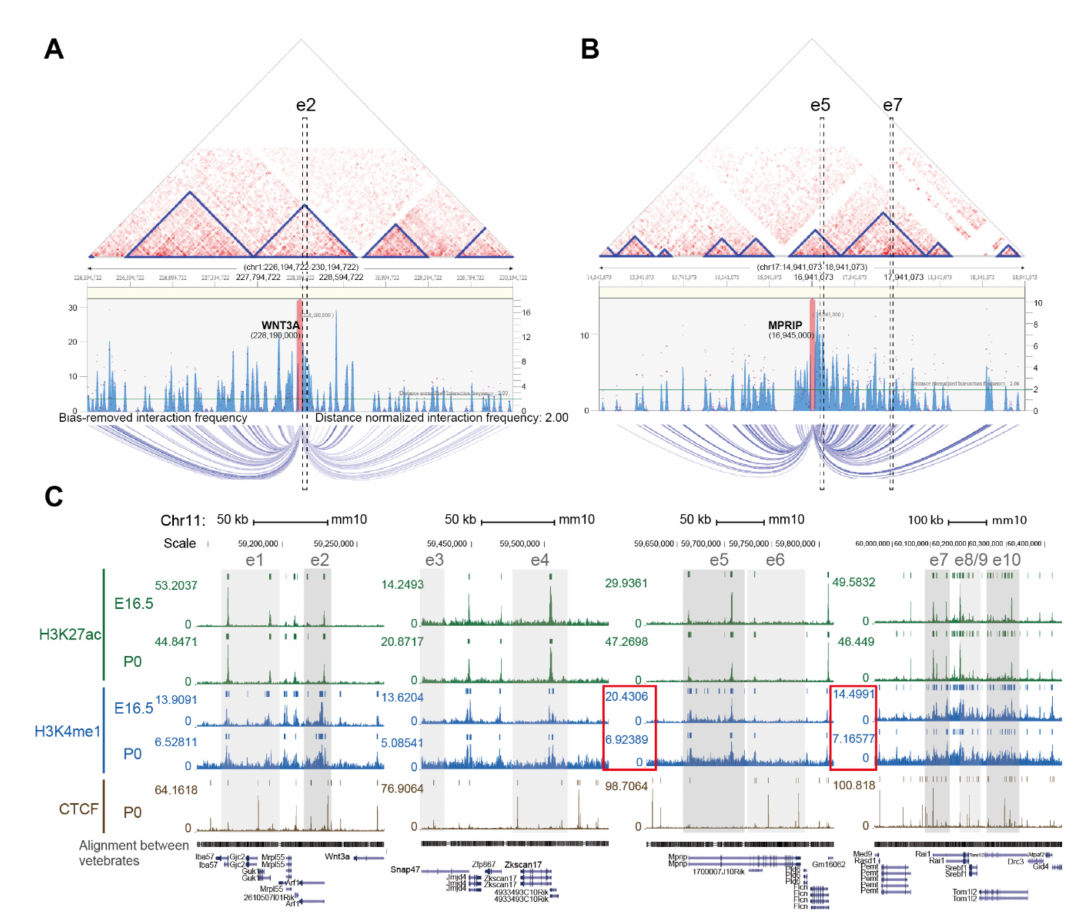
Figure 4. Interactions of transcriptional activation domains and histone modifications at the e5 and